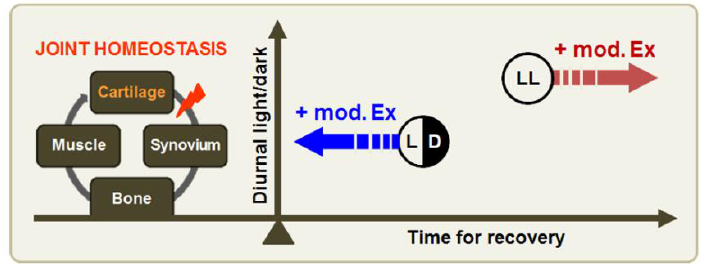
Figure 5. Exercise-induced benefits depend on environmental lighting conditions. Joint homeostasis is organically regulated by the actions of cartilage, synovium, bone, and skeletal muscles. Inflamed cartilage disrupts the homeostatic balance in the osteoarthritic joint; the degree to which this occurs might be aggravated under constant-lighting conditions. Additionally, joint damage may be exacerbated, instead of restored, when regular, moderate-intensity exercise is added in the context of aberrant light/dark cycles. Thus, lighting condition might be an important environmental factor when looking to restore homeostasis following joint damage.